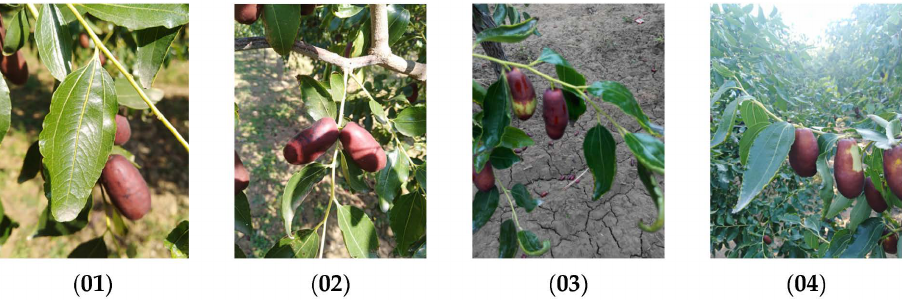
Figure 1. Sample images under different environments: ( 01 ) Occluded leaves; ( 02 ) Sunlight angle; ( 03 ) Soil background; ( 04 ) Leaves background.